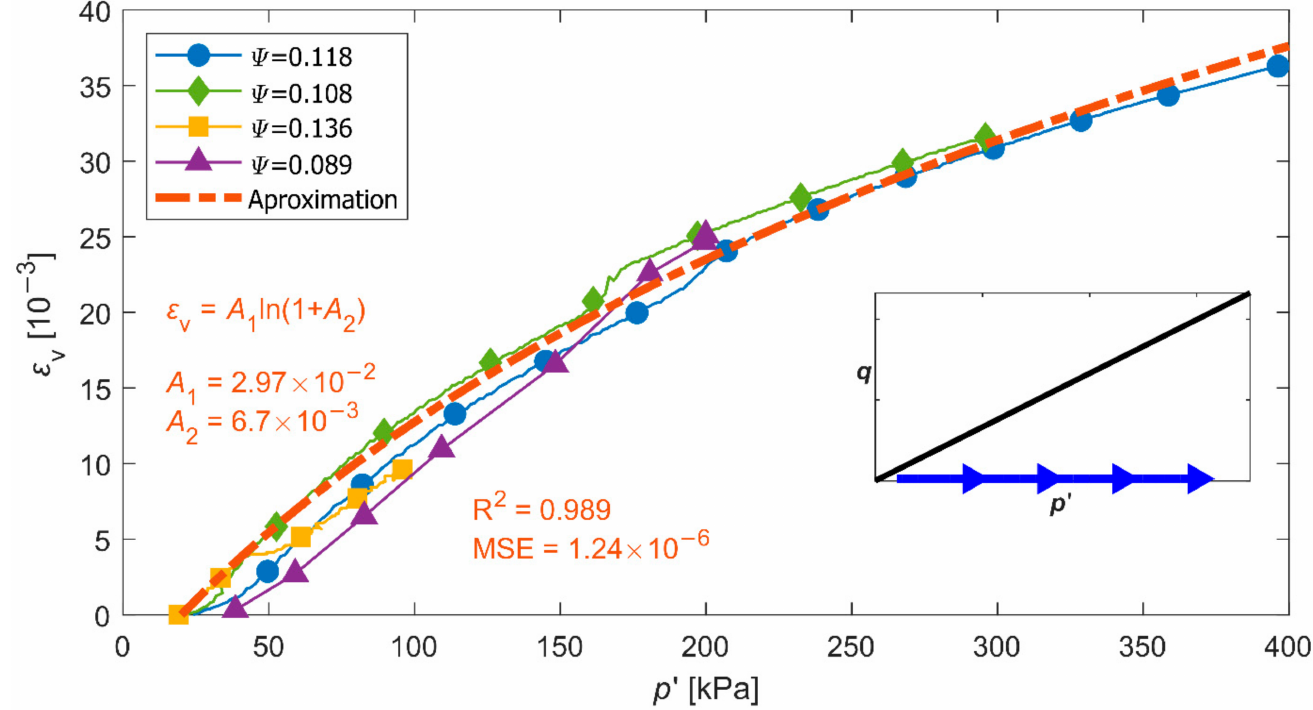
Figure 16. Volumetric strains developed during isotropic consolidation in OZM50